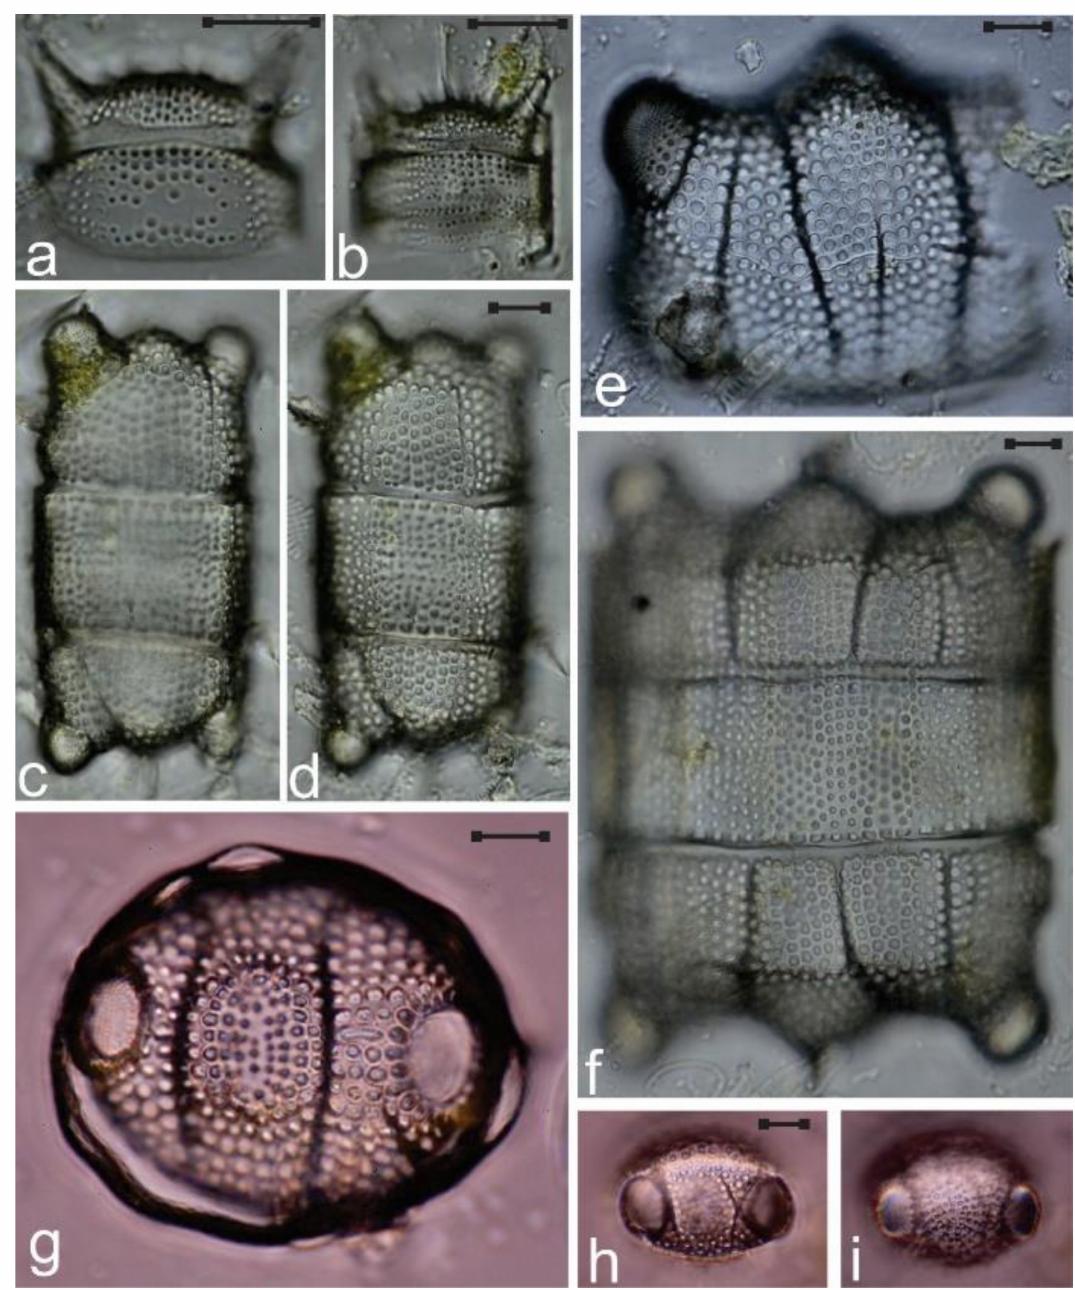
Figure 12. ( a , b ) Odontella rostrata; ( c – i ) Biddulphia biddulphiana images c , d , f frustule in girdle view showing the cingulum with full set of girdle bands. Scale bar = 10 µ